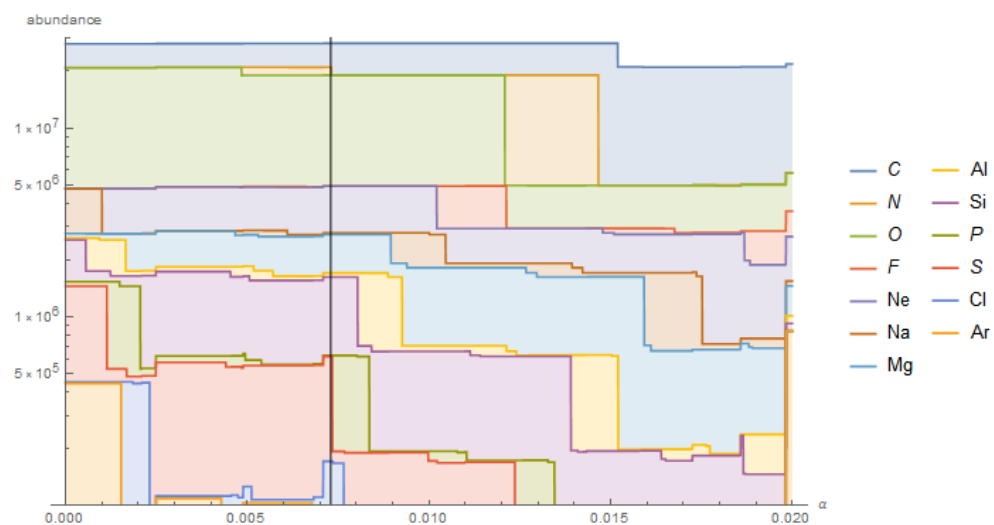
Figure 2. The abundances of second and third row elements, restricted to the maximally sensitive direction in parameter space described in the text, and parameterized by α . The black line denotes our observed values. The elements are ordered from the upper right downward.